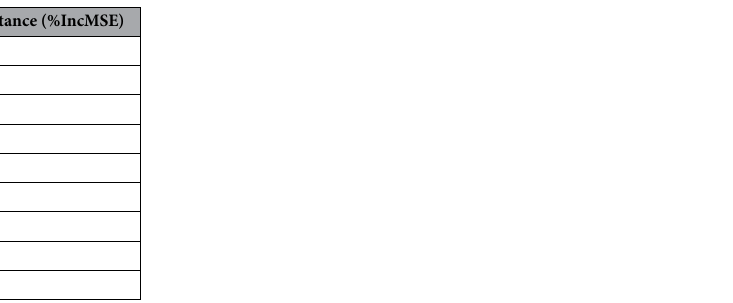
Table 6. The RF model with selected, presented variable importance in descending order based on % IncMSE.